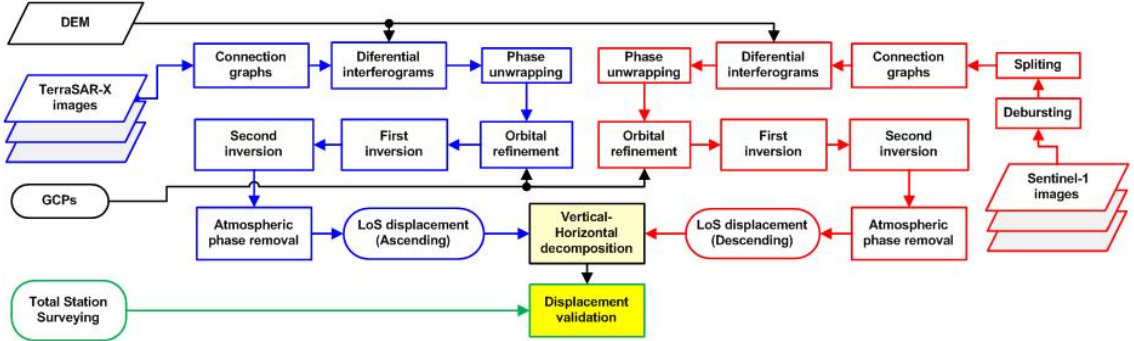
Figure 2. Data processing flow chart.